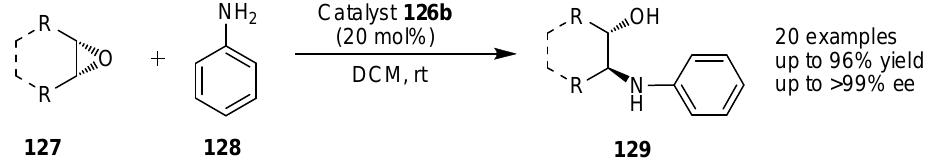
Scheme 38. Asymmetric epoxide ring opening with anilines.